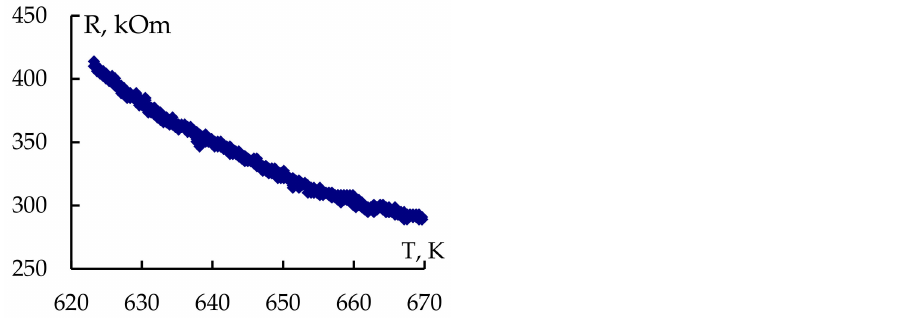
Figure 15. Typical image of temperature dependency of net-like sample produced using sol–gel method.